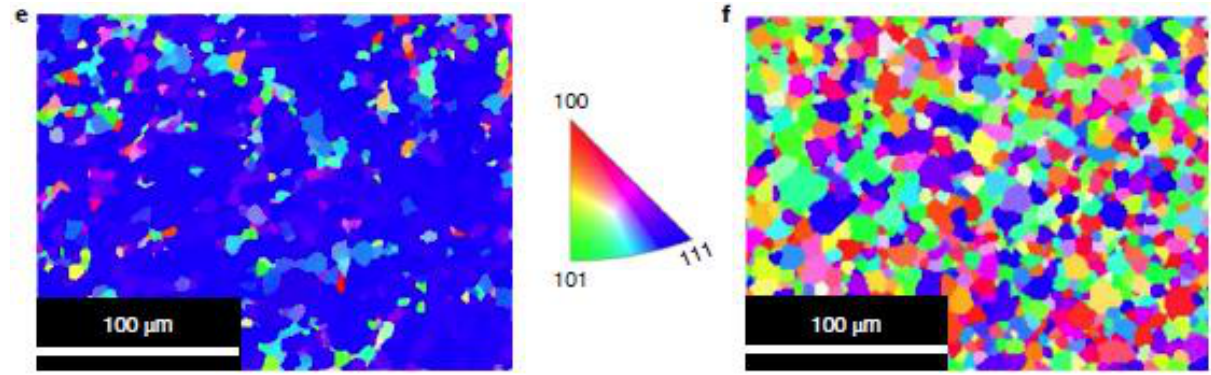
Figure 3. Texture quality of Na 0.5 Bi 0.5 TiO 3 – Sr 0.7 Bi 0.2 TiO 3 (NBT-SBT) multilayer ceramics. ( a ) SEM image of the fracture surface of <111>-textured NBT-SBT MLCC. ( b ) SEM image of the fracture surface of nontextured NBT-SBT MLCC. ( c , d ) X-ray diffraction patterns of the <111>-textured NBT-SBT multilayer ceramic and its nontextured counterpart. ( e , f ) Grain orientations for the <111>-textured NBT-SBT multilayer ceramic and its nontextured counterpart [48].